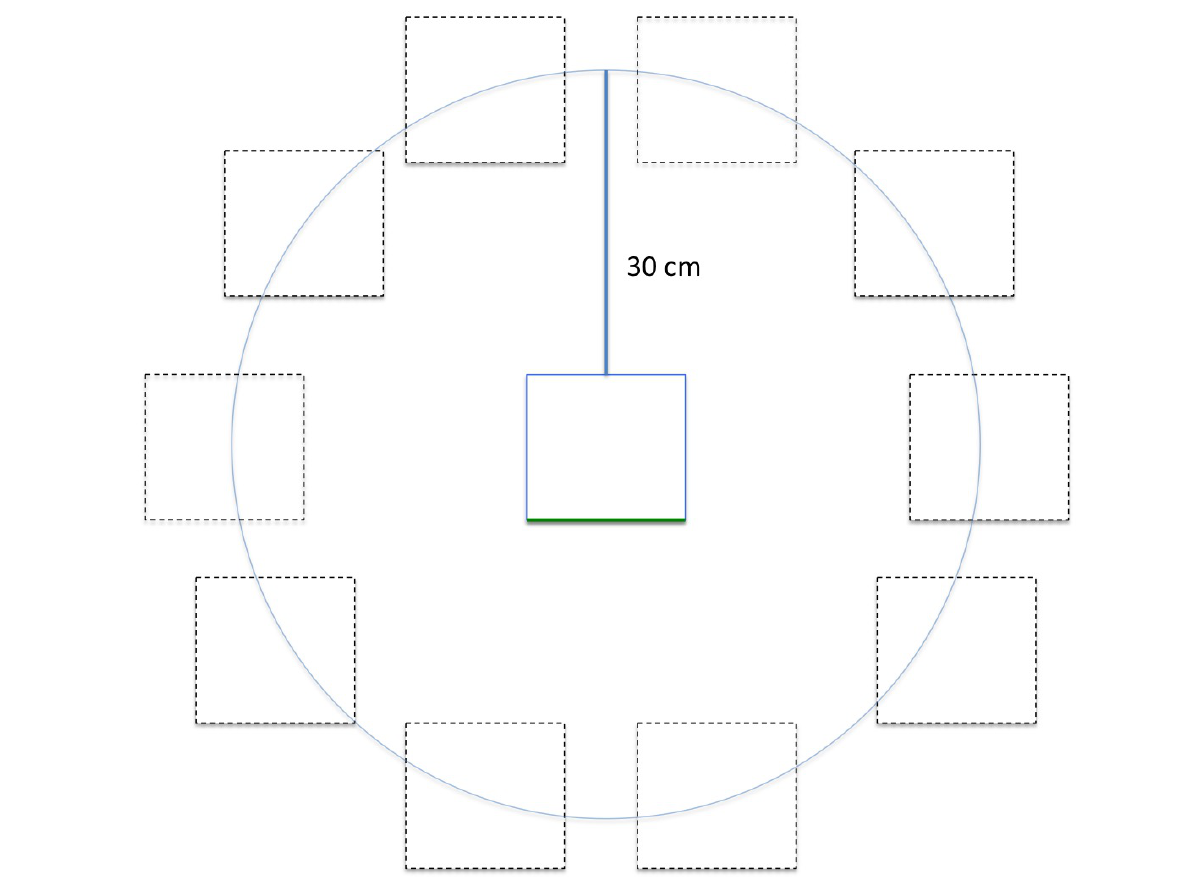
Figure 5. Diagram of target and cube spawn positions: cubes spawned (appeared) at one of 10 positions located 30 cm from the